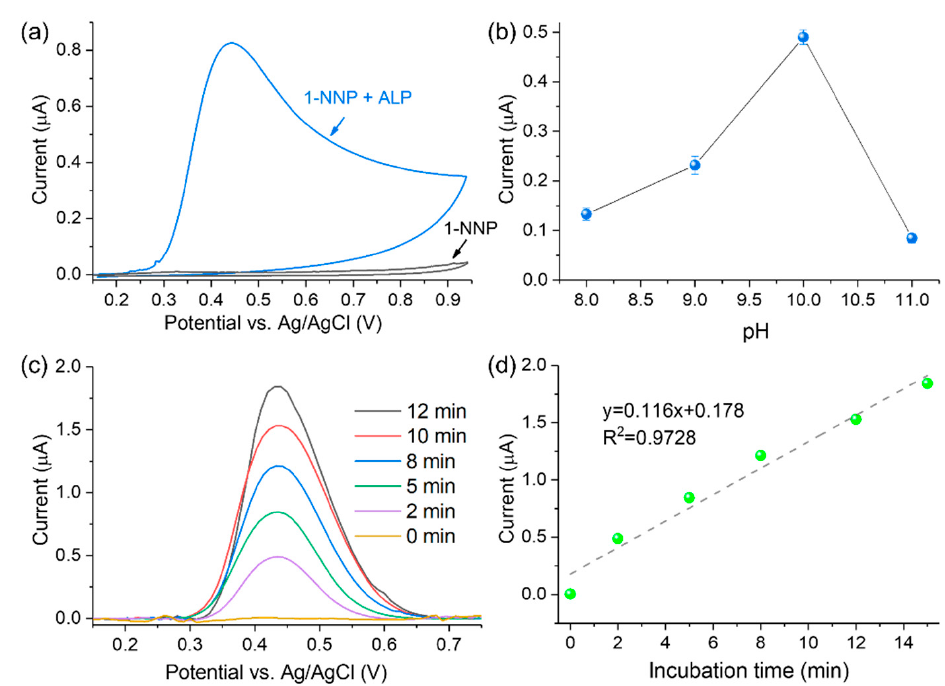
Figure 4. ( a ) CV test of ALP activity with 1-NPP as substrate; ( b ) pH optimization for the ALP activity detection ( n = 3); ( c ) optimization of the incubation time for the ALP activity test (ALP activity is 100 U/L, and 2 M phosphoric acid used as stop solution); ( d ) linear relationship between the DPV current and incubation time.